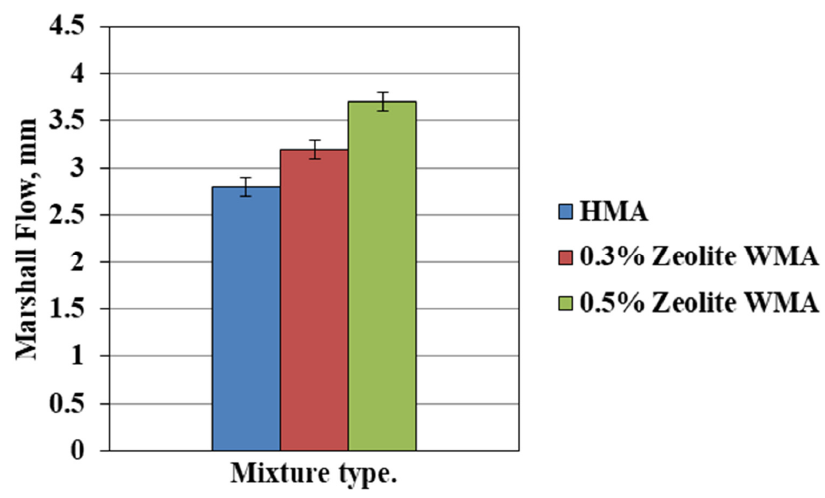
Figure 5. Marshall Flow results.